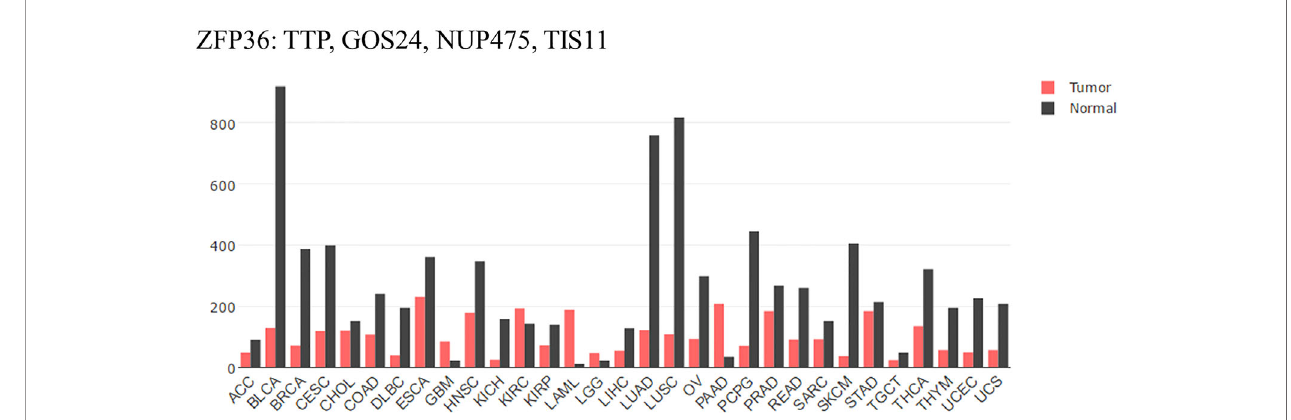
FIGURE 1 | TTP/ZFP36 expression in cancer and normal tissues analyzed by GEPIA. Compared with normal tissues analyzed by GEPIA; TTP mRNA expression is signi fi cantly lower in the tissues of most forms of carcinoma. ACC, Adrenocortical carcinoma; BLCA, Bladder urothelial carcinoma; BRCA, Breast invasive carcinoma; CESC, Cervical squamous cell carcinoma; CHOL, Cholangiocarcinoma; COAD, Colon adenocarcinoma; DLBC, Lymphoid Neoplasm Diffuse Large B-cell Lymphoma; ESCA, Esophageal carcinoma; GBM, Glioblastoma multiforme; HNSC, Head and Neck squamous cell carcinoma. KICH, Kidney Chromophobe; KIRC, Kidney renal clear cell carcinoma; KIRP, Kidney renal papillary cell carcinoma; LAML, Acute Myeloid Leukemia; LGG, Brain Lower Grade Glioma; LIHC; liver hepatocellular carcinoma; LUAD; lung adenocarcinoma; LUSC; lung squamous cell carcinoma; OV, ovarian serous cystadenocarcinoma; PAAD, pancreatic adenocarcinoma; PCPG, Pheochromocytoma and Paraganglioma; PRAD, Prostate adenocarcinoma; READ, Rectum adenocarcinoma; SARC, Sarcoma; SKCM, Skin Cutaneous Melanoma; STAD, Stomach adenocarcinoma; TGCT, Testicular Germ Cell Tumors; THCA, Thyroid carcinoma; THYM, Thymoma; UCEC, Uterine Corpus Endometrial Carcinoma; UCS, Uterine Carcinosarcoma